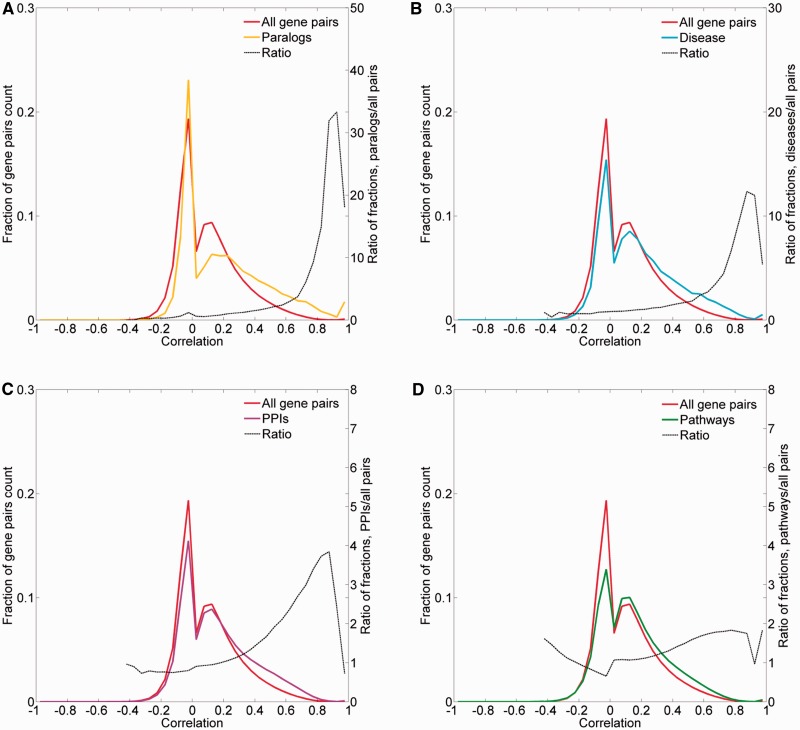
Pairwise correlation distribution. The fraction distribution of the pairwise Pearson’s correlation coefficients for the 16 900 proteome-annotated genes is plotted along gene pairs sharing functional attributes, namely: (A) sequence paralogs, (B) diseases, (C) PPIs and (D) biological pathways. The ratio between compared fractions distributions was plotted, disregarding bins with extremely low (<8 × 10−5) fraction values.